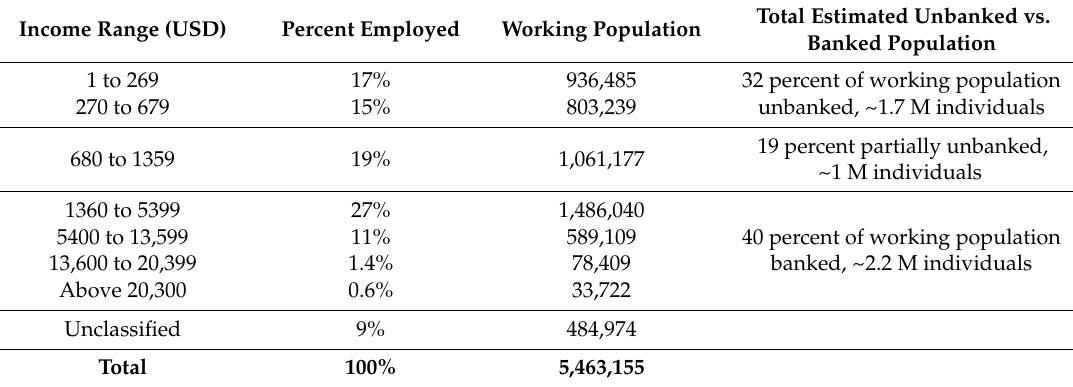
Total Estimated Unbanked